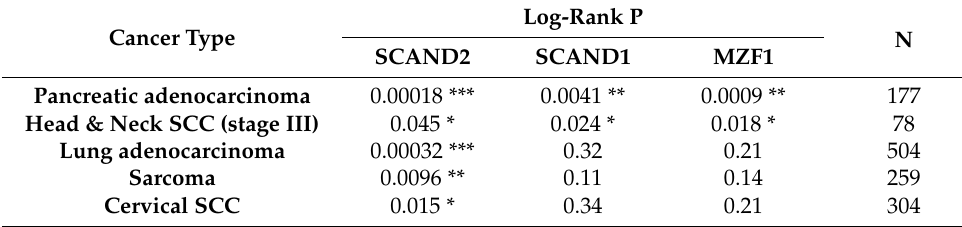
Figure 8. Kaplan–Meier plots showing prognostic values of SCANDs, MZF1 , and HSP90 gene expression in pancreatic cancer. Data were from TCGA PanCancer Atlas, pancreatic adenocarcinoma (PAAD), n = 177. High expression of SCANDs and MZF1 genes ( A – C ) are correlated with better prognoses whereas high expression of HSP90 genes ( D – F ) are correlated with poor prognosis of pancreatic DAC. Data in panels A and C were published in: Eguchi, T., et al., 2022 [43]. Table 7. SCAND1, SCAND2, and MZF1 expression correlate with enhanced prognoses in